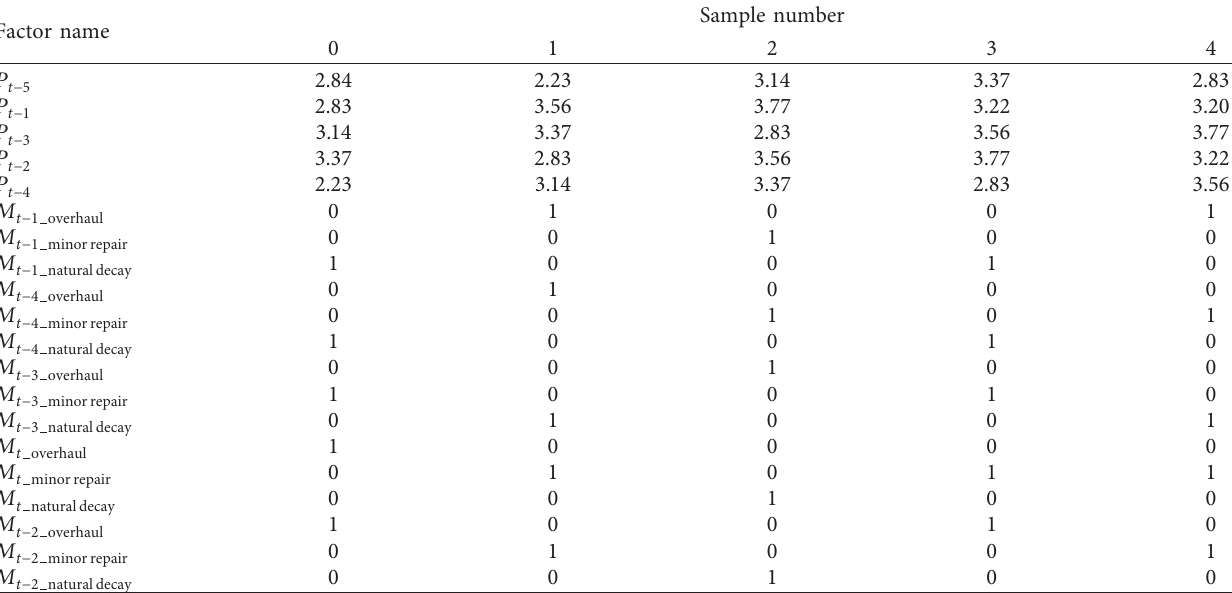
Table 3: All X factors after one-hot